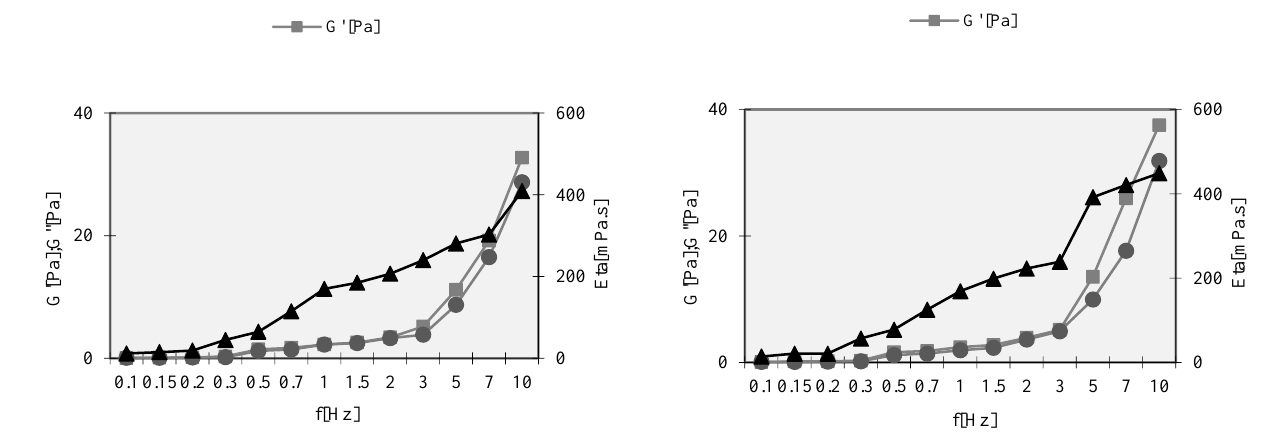
Figure 9. Rheology studies of formulation F2 ( left ) and formulation F7 ( right ). The analysis by transmission electron microscopy (TEM) is shown in Figure 10. The a–c images were obtained on the day of production and d–f were obtained 28 days after production. During this time, the samples were kept at 4 °C. NE droplets are clearly visible, and the droplet size analysis was performed by the software of the Tecnai TM G 2 Spirit BioTWIN microscopic. The shape of the droplets was spherical in all formulations and the appearance maintained similar after 28 days of production (Figure 10d–f).